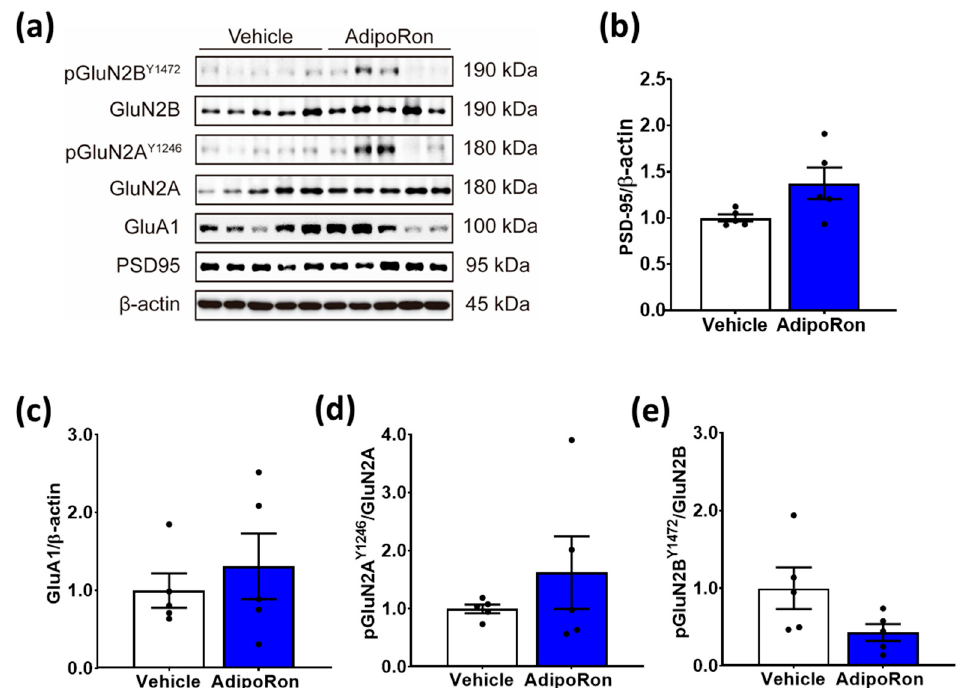
Figure 6. Sub-chronic AdipoRon treatment did not change the expression of synaptic NMDA receptor subunits in the hippocampus. ( a ) Representative images of Western Blot of vehicle- and AdipoRon-treated mice. Seven-day AdipoRon treatment did not significantly change the protein expression of ( b ) PSD-95, ( c ) GluA1 subunit of AMPA receptors, ( d ) GluN2A, or ( e ) GluN2B subunits of NMDA receptors. Student t-test. Data presented as mean ± SEM.